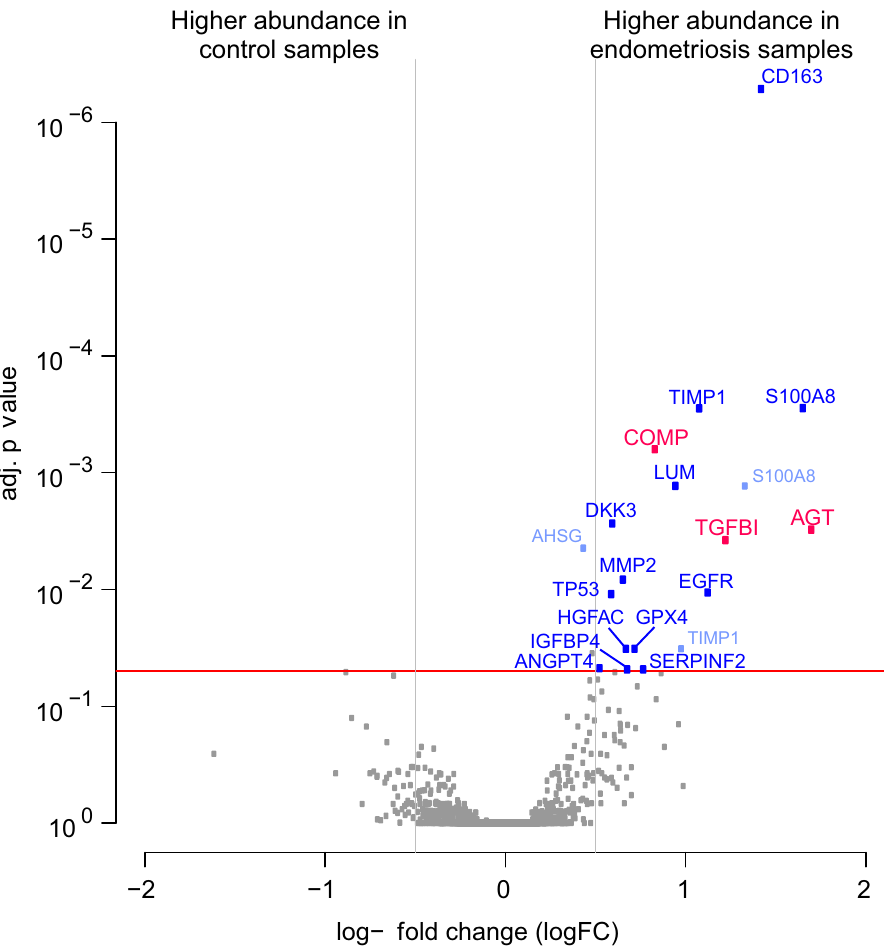
Figure 2. Volcano plot of the protein array data to visualise the adjusted p values and the corresponding log- fold changes (logFC). Horizontal red line, adjusted p = 0.05; vertical lines, logFC cut-offs (IlogFCI > 0.5). Proteins with positive logFC had higher levels in the peritoneal fluid of the cases versus controls; and vice versa for proteins with negative